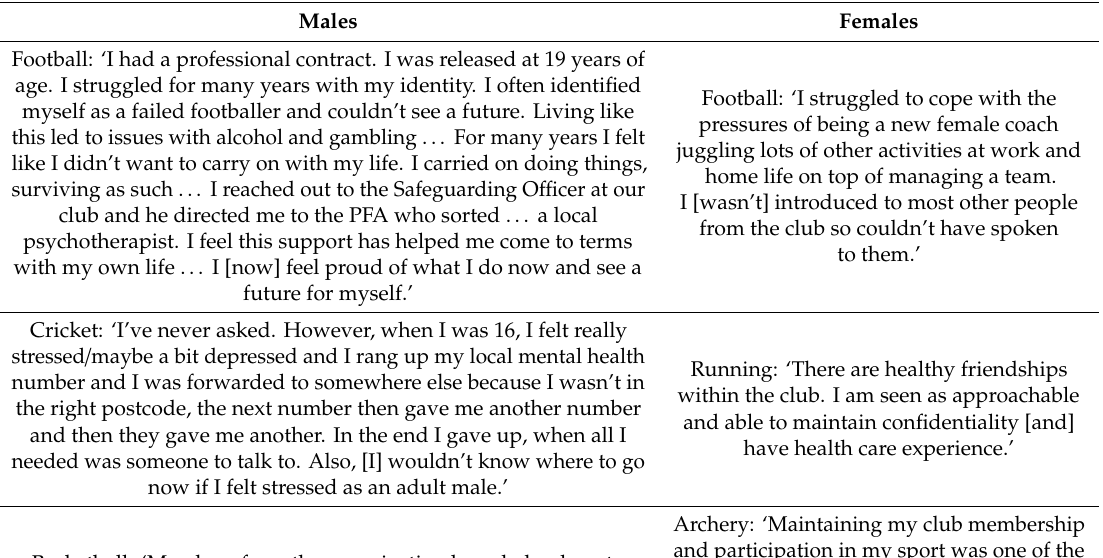
Table 8. Coaches’ responses to whether they had received support for their mental health from others in their